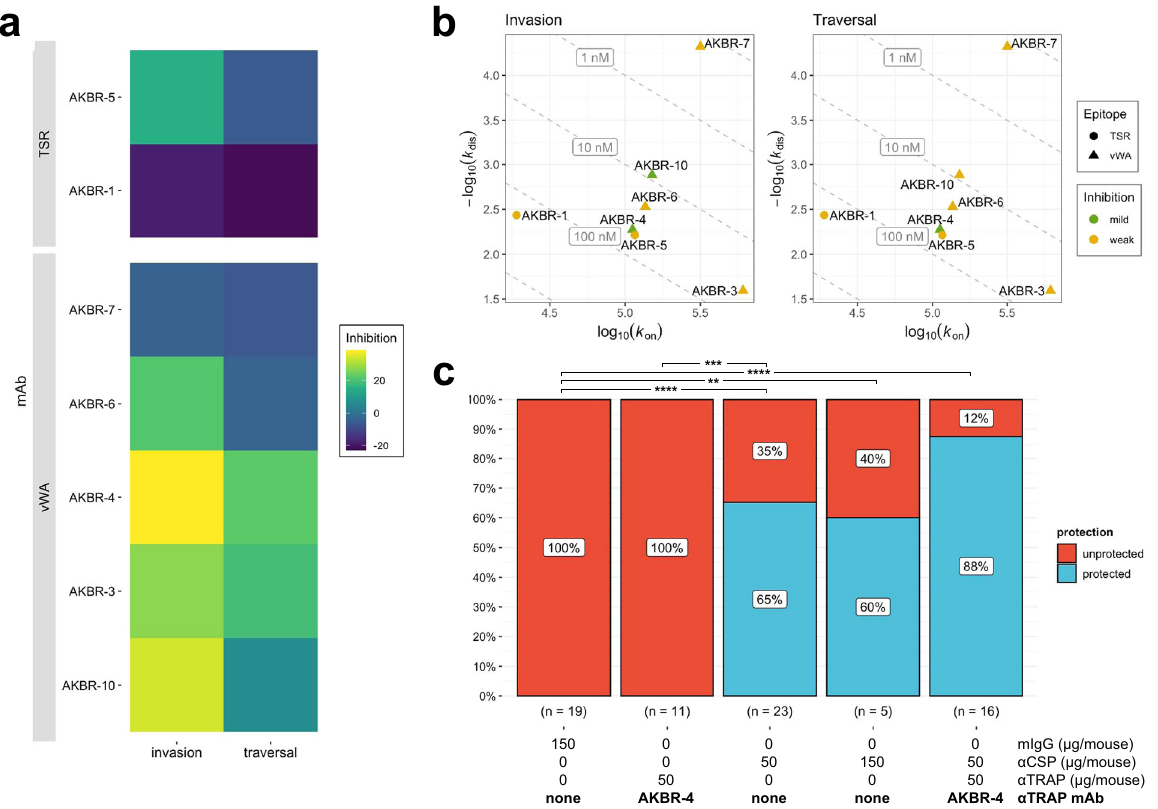
Fig. 5 Effects of monoclonal PfTRAP antibodies on parasite activity. a Each mAb was assessed for in vitro function of inhibition of invasion and traversal. In each case, mean values of % inhibition (i.e., 100% — invasion or traversal value) from the 100-µg/mL mAb concentrations (bar plots with these and additional conditions shown in Suppl. Fig. 5) are represented on a color axis. b Binding kinetics for each mAb was measured by BLI and shown as kinetic maps with gray dashed diagonal contour lines labeled with the corresponding K d values and symbols representing the characterized epitopes for invasion (left) and traversal (right) inhibition. Higher-af fi nity (i.e., those possessing lower K d values) mAbs are closer to the upper-right corner of this plot. Symbol color coding represents “ mild ” inhibition for values ≤ 70% and “ weak ” for mean values >70% observed at the 100-µg/mL concentration. c Summarized sterile protection breakdowns following passive-transfer-challenge experiments (number of animals in each group is shown below the corresponding bar, individual values shown in Table 2). For c , ** is p ≤ 0.01, *** is p ≤ 0.001, and **** is p ≤ 0.0001; the values reported were not adjusted for multiple comparisons due to small group sizes and limited